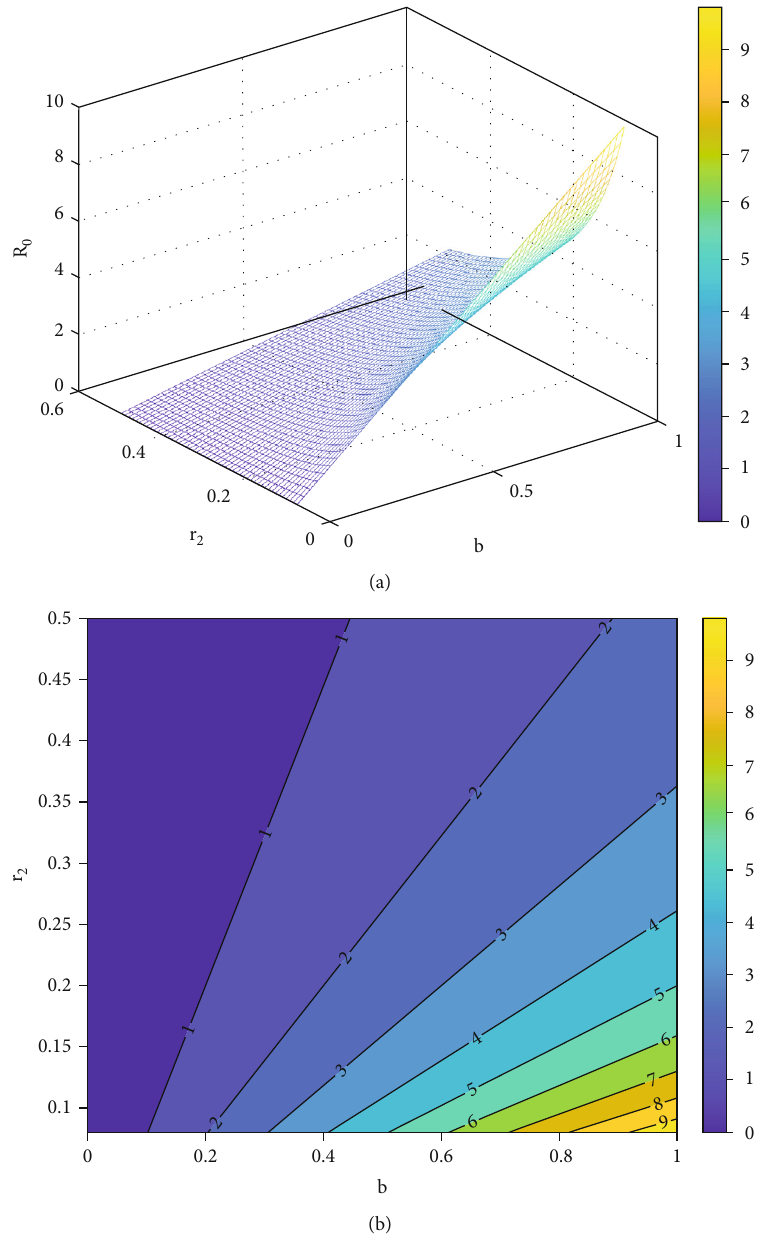
R b and r 0 vs. 2 ,